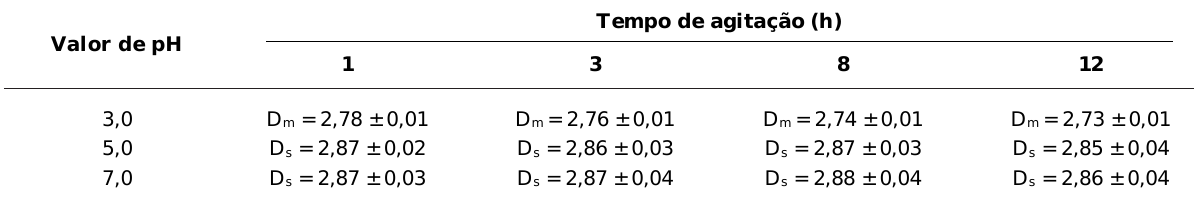
Quadro 1. Valores da dimensão fractal de suspensões de AH-Espodossolo